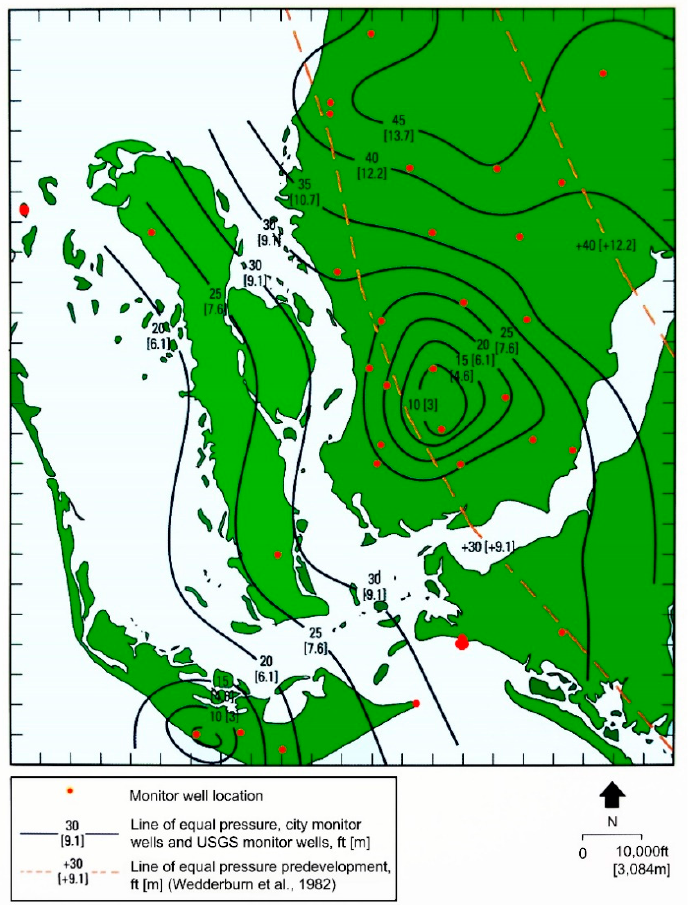
Figure 9. Pumping-induced lowering of the potentiometric surface of the Lower Hawthorn Aquifer in November 1990 (from [12,21].